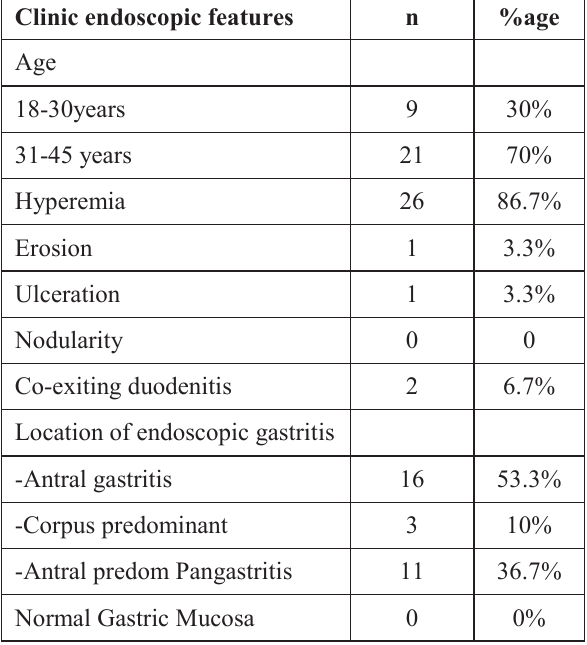
Table-1: Distribution of cases with respect to clinical